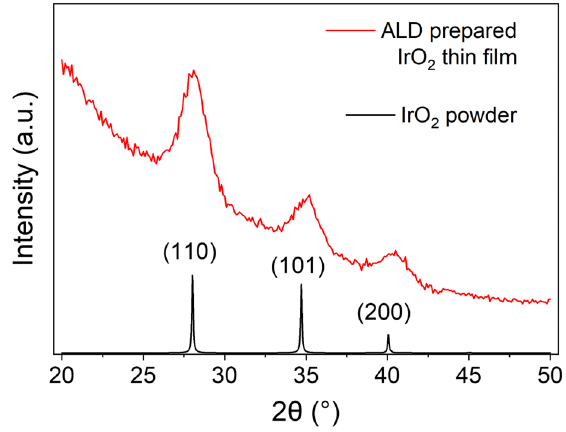
Figure 3. GI-XRD results for IrO 2 thin film prepared by 600 ALD cycles, corresponding to about 14.8 nm (red line). Angle of incidence ω is 0.2 ◦ . The results are compared with the XRD pattern for rutile IrO 2 powder (black line) calculated with the Mercury Software using the structure deposited on the Cambridge Structural Database as ICSD 640885, deposition number 1,759,474 [36,37]. The average grain size of IrO 2 , determined by Scherrer’s formula, is 5.3 nm ± 0.4 nm.